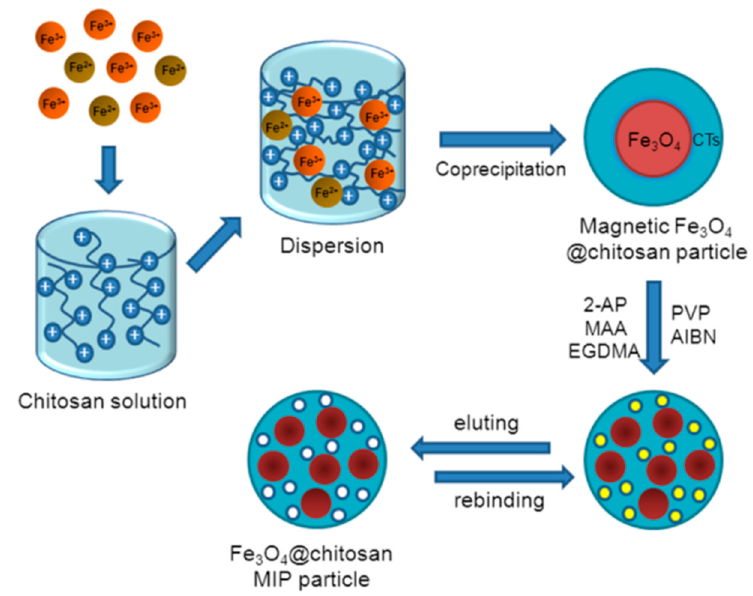
Figure 1. Scheme of preparation of Fe 3 O 4 -CTs@MIP.